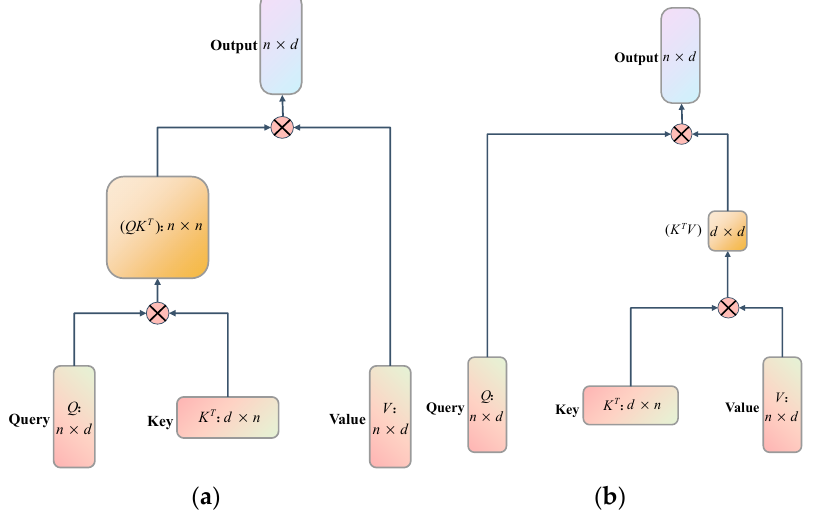
Figure 2. ( a ) Traditional Attention mechanism; ( b ) Linear Attention mechanism, where the rectangle size intuitively reflects the dimension of the matrix and the required amount of computations.